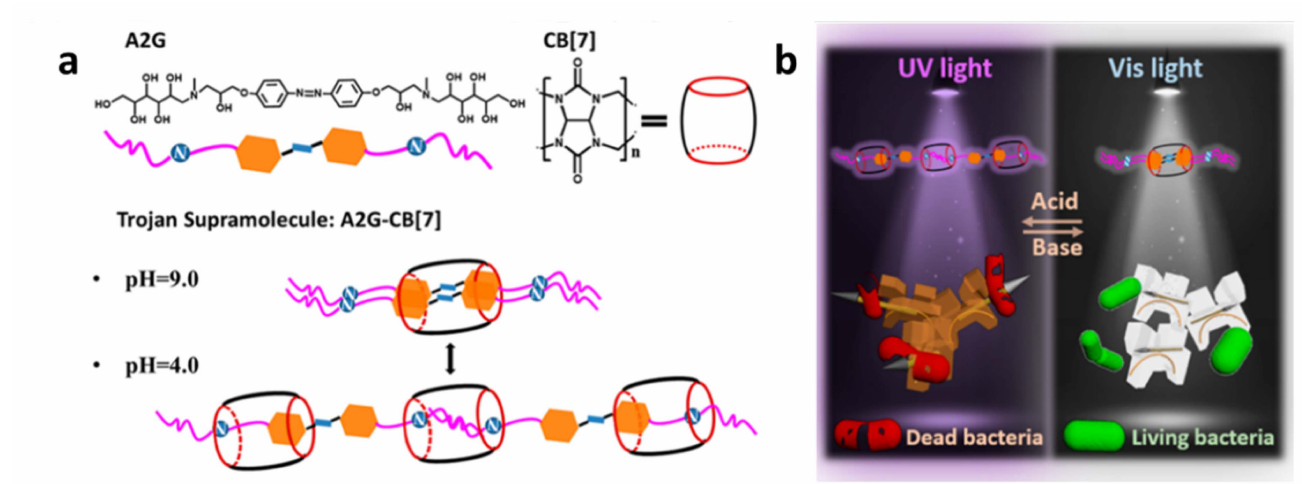
Figure 27. Diagram of ( a ) the chemical structures of A2G, CB[7], and the formation process of A2G- CB[7]; ( b ) effects of A2G-CB[7] on bacteria under different pH and light conditions (reproduced with permission of American Chemical Society from ref.